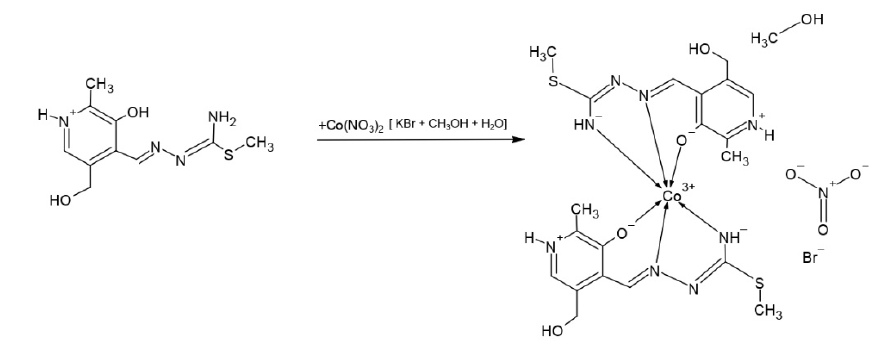
Table 1. Crystal data and structure refinement details of compound 1 .